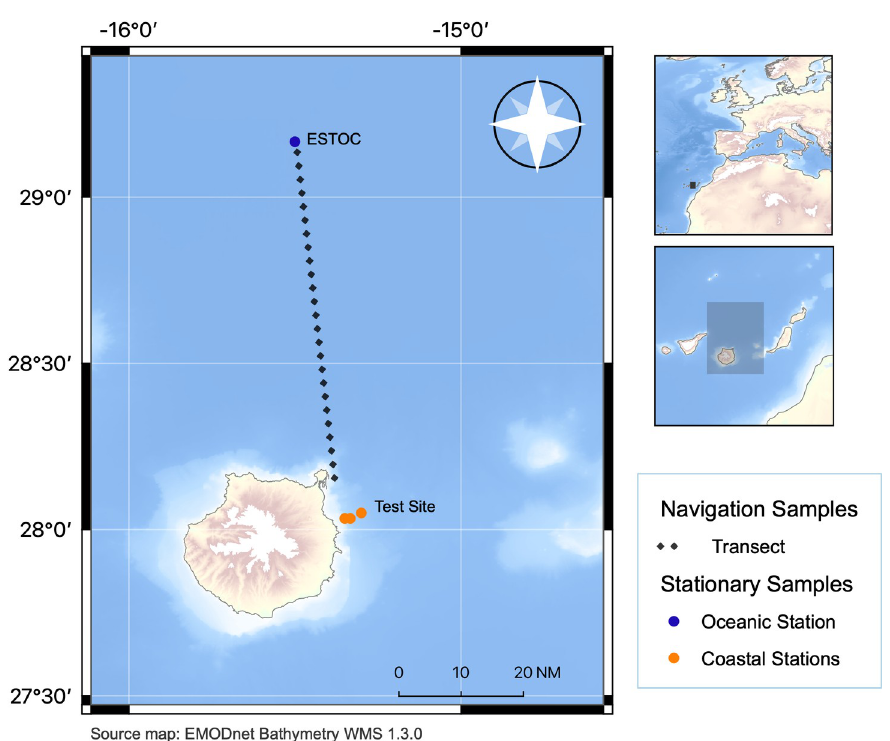
Fig 1. Map of sampling locations repeated on the three research cruises. (i) oceanic stations corresponding to the ESTOC station, (ii) coastal stations corresponding to three stations at the PLOCAN Test Site, 2 nautical miles off the coast of Gran Canaria, and (iii) navigation samples collected during the transit to and from ESTOC and the home port, a distance of approximately 60 nautical miles per transect. Coordinates are presented in Table 1. This figure was generated using the free and open source software QGIS [54].